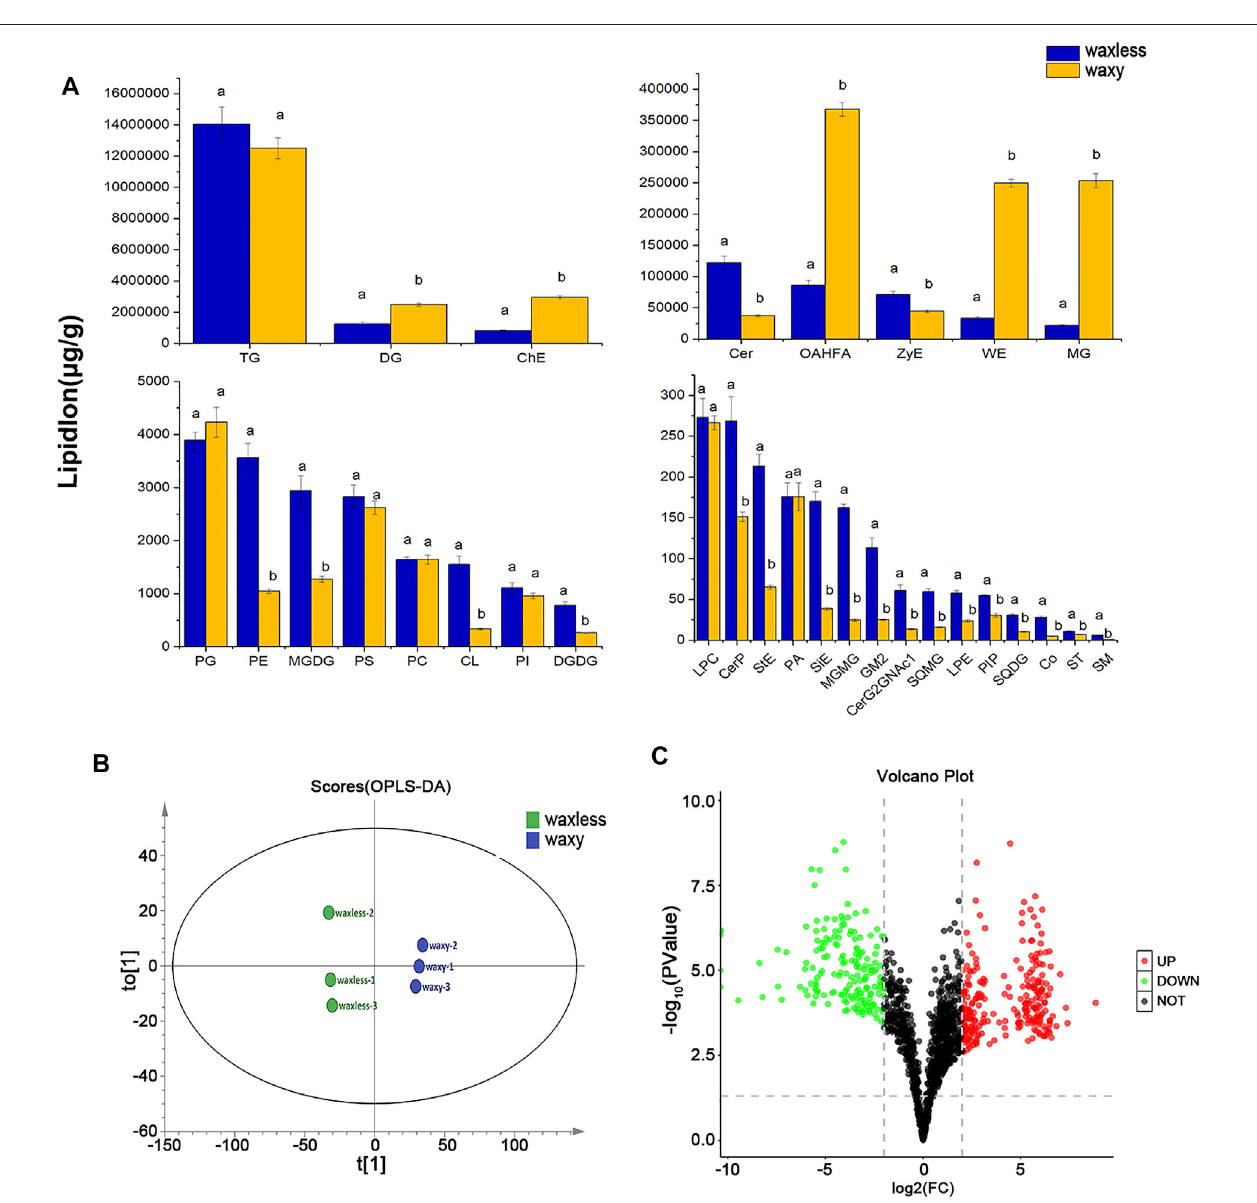
FIGURE 4 | Differential expression of wax-related lipids between waxless and waxy . (A) Content of lipid subclasses in the leaf epidermis of two wheat mutants, abscissa is the lipid subclass, ordinate is the lipid subclass content, blue is the low-wax mutant waxless , yellow is the multi-wax mutant waxy , and the letters indicate signi fi cantdifferences ( p < 0.05). (B) OPLS-DA score map, “ t[1] ” represents principal component1, “ to[1] ” represents principal component 2, and the ellipse represents 95% con fi dence interval. Dots of the same color represent each biological weight in the group waxles s and waxy . (C) Volcano plot, abscissa is log 2 FC ( waxless / waxy ) and ordinate is − log 10 ( p value). Each dot represents a lipid ion, red represents upregulated lipid ions, green represents downregulated lipid ions, and black indicates undifferentiated lipid ions (FC > 4 or < 0.25, VIP > 1, p <